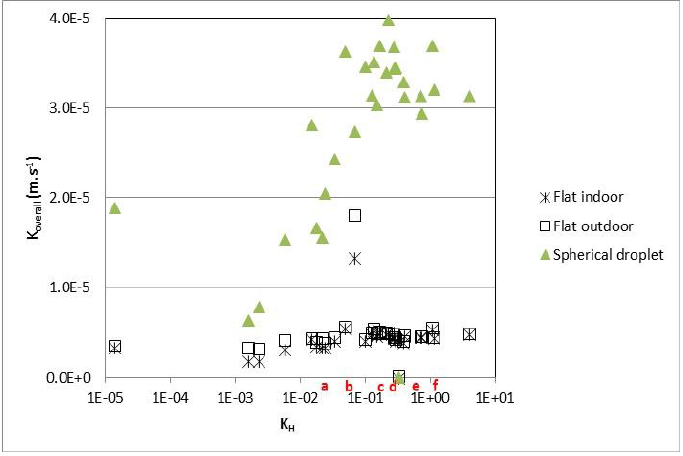
Figure 1. Overall mass-transfer coefficients as a function of K b-hexachlorobenzene, c-chloroform-dichloromethane, d-BTEX (benzene, toluene, ethylbenzene and xylene), e-trichloroethylene-tetrachloroethylene, f-carbon